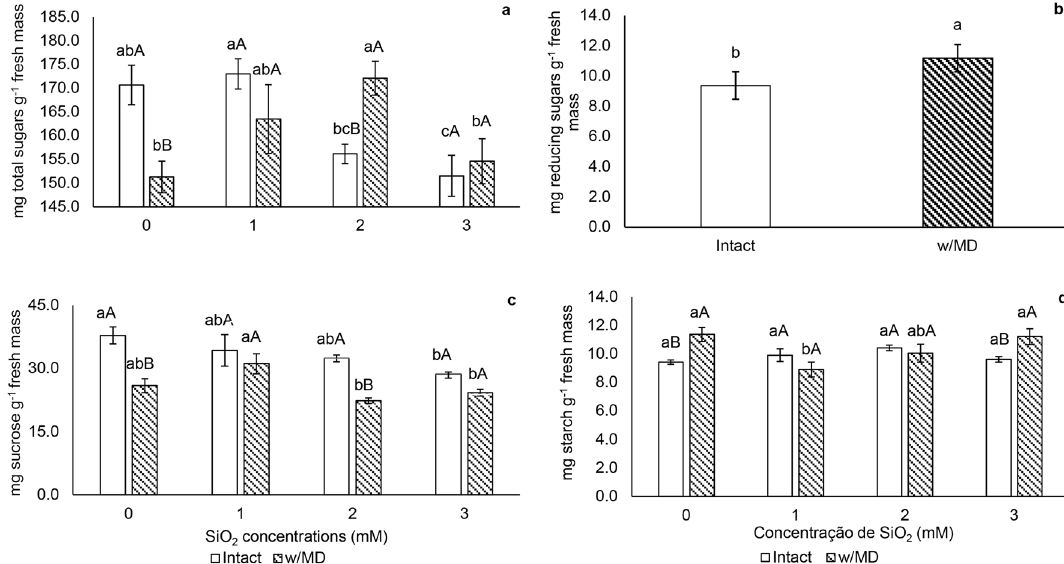
Figure 5. Carbohydrates. ( a ) Total sugars (p < 0.05); ( b ) reducing sugars (p < 0.04); ( c ) sucrose (p < 0.04); ( d ) starch (p < 0.05) in Passiflora incarnata L. with mechanical damage (w/MD) and without mechanical damage (intact), subjected to SiO 2 variations. Values corresponding to the averages ± SE. Capital letters compare plants with and without mechanical damage and lower letters compare SiO 2 variations. Reducing sugars results were significant only for mechanical damage presence/absence. Other results were significant for the interaction between SiO 2 variations and the presence/absence of mechanical damage.